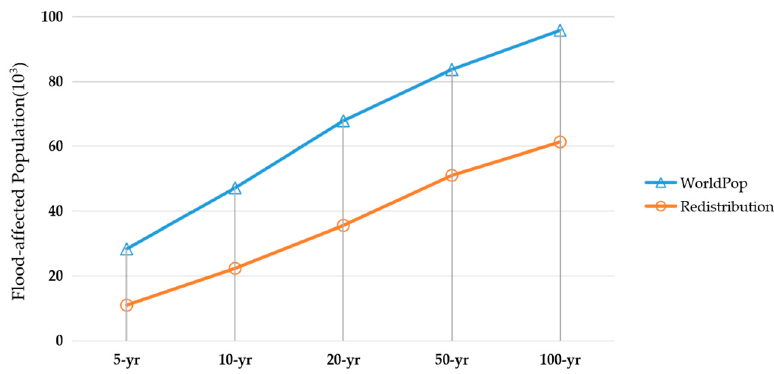
Figure 8. Comparison of the number of people affected by urban flooding in multiple scenarios (5, 10, 20, 50, and 100 yr return periods).